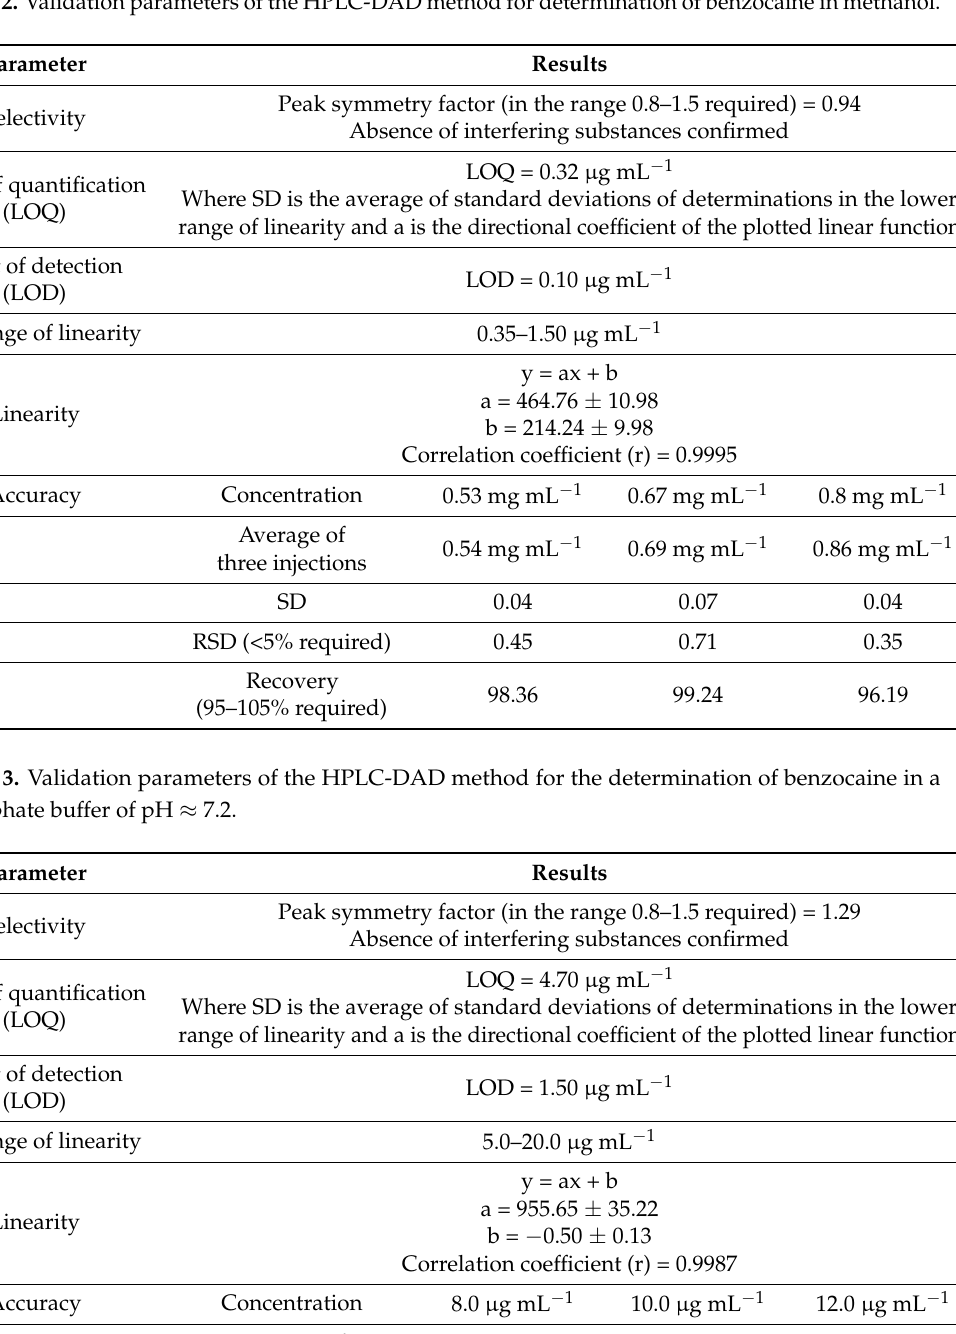
Table 2. Validation parameters of the HPLC-DAD method for determination of benzocaine in methanol.